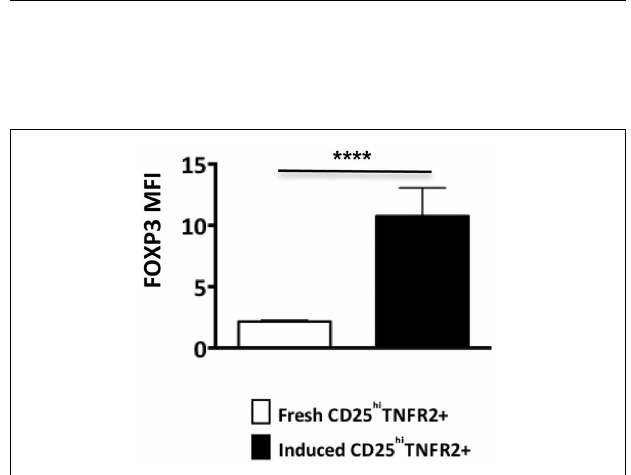
FIGUREA1 | Phenotype of inducedTNFR2 + T cells from CD4 + CD25 − T cell, CD4 + CD25 + T cells, and un-fractionated CD4 + cells. Expression of regulatory molecules onTNFR2 subsets from starting population CD4 + CD25 − T cells, CD4 + CD25 + T cells, and un-fractionated CD4 + T cells. Gray histograms represent isotype staining while clear histogram represents the indicated molecule.The numbers indicate percentage positive for the represented molecular marker.